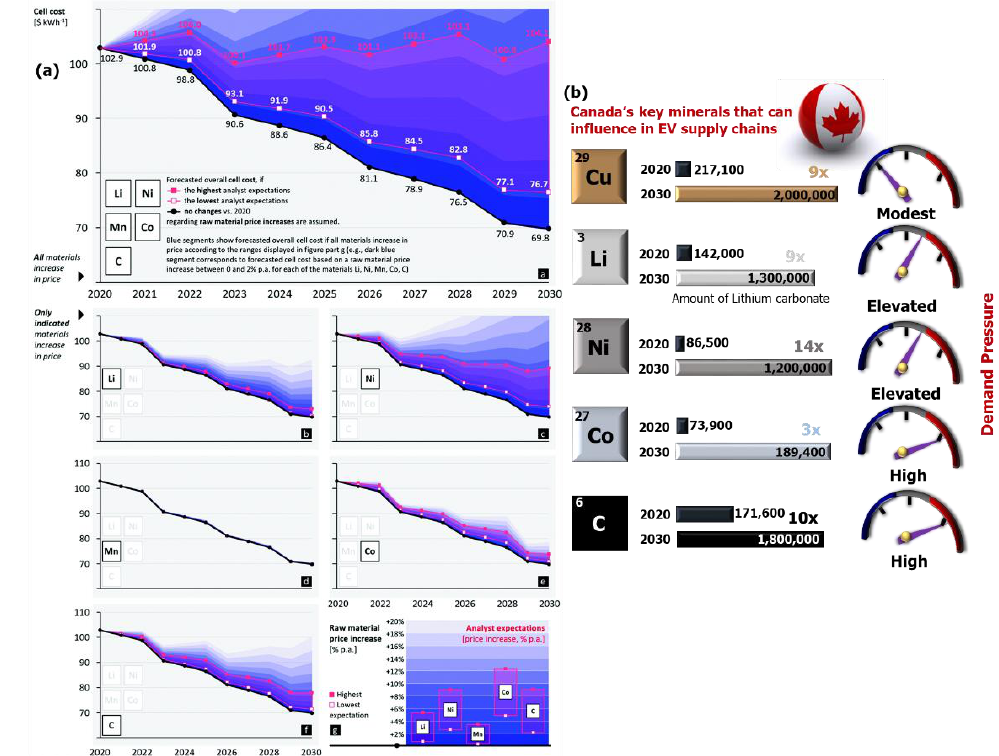
Figure 3. ( a ) Impact of increasing raw material prices on cell cost throughout 2030 for 5 materials alongside analyst expectations for raw material price developments, reprinted with permission from [7]. Copyright 2022, The Royal Society of Chemistry. ( b ) Summary of the key minerals that could help Canada gain a major influence in the EV supply chain, along with demand pressure on the right side [8].